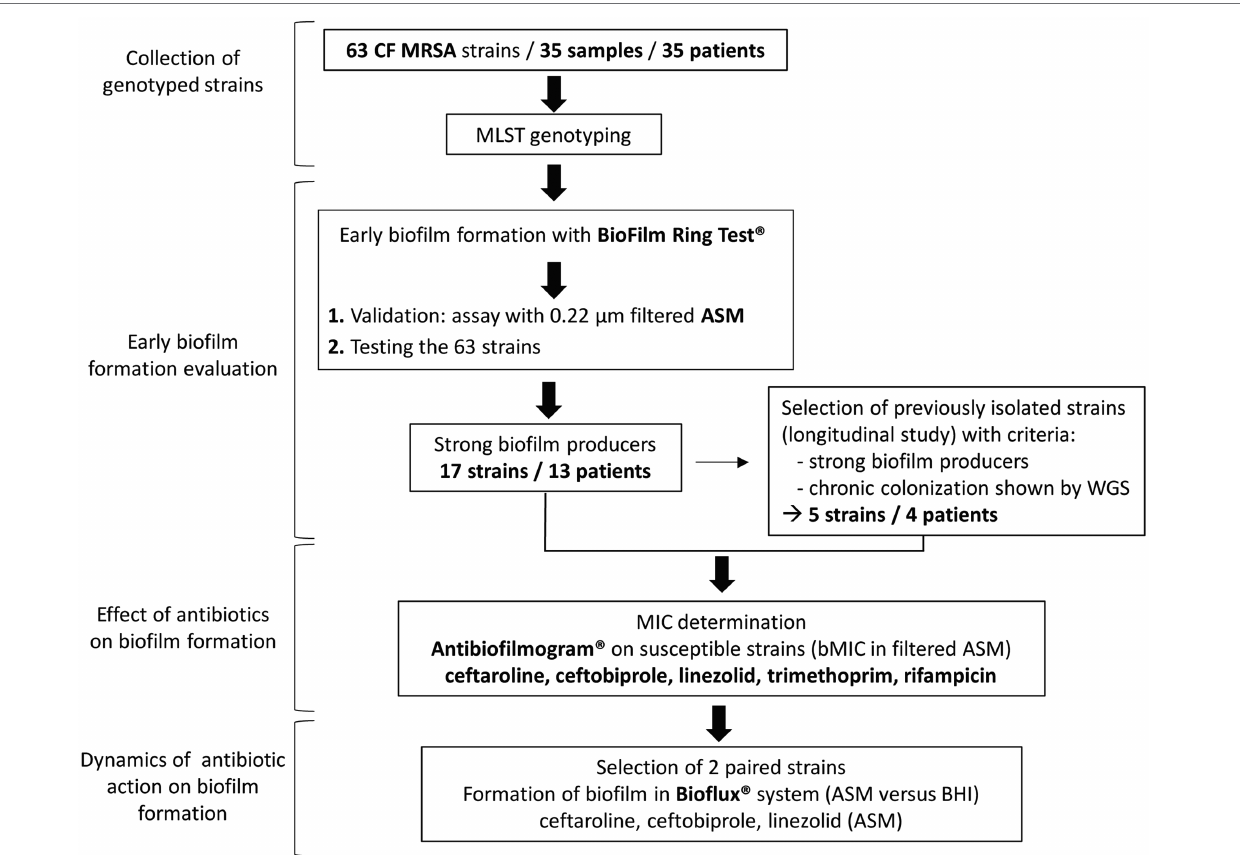
FIGURE 1 | Flowchart showing the main steps of the study. CF, cystic fibrosis; MRSA, methicillin-resistant Staphylococcus aureus ; MLST, multilocus sequence typing; ASM, artificial sputum medium; WGS, whole-genome sequencing; MIC, minimum inhibitory concentration; bMIC, biofilm MIC; and BHI, brain heart infusion